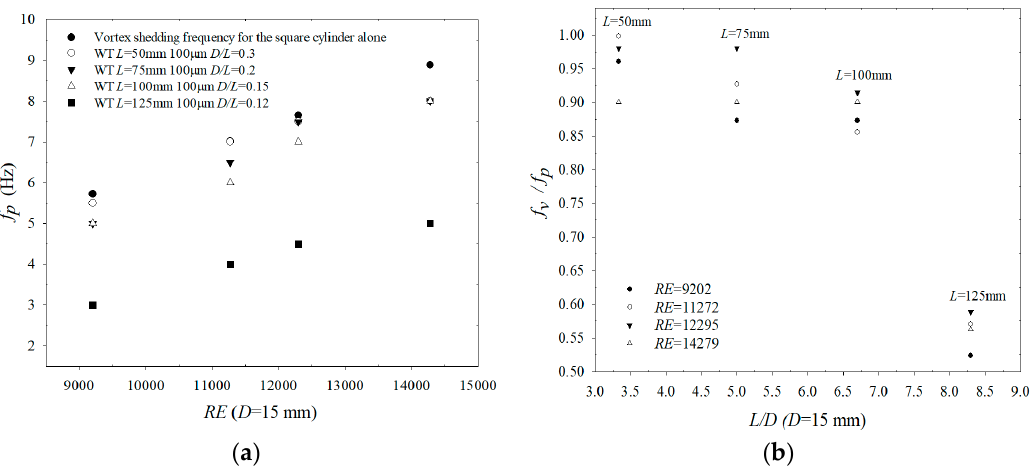
Figure 12. Water tunnel data. ( a ) Vortex shedding frequency and flapping frequencies of the plates; ( b ) Square cylinder vortex shedding-frequency-to-flapping-frequency ratio.